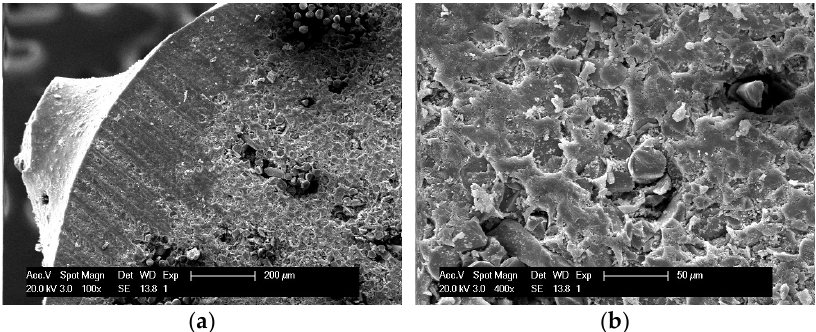
Figure 9. Microstructure of unconditioned G1: ( a ) 100 × G1; ( b ) 400 × G1.